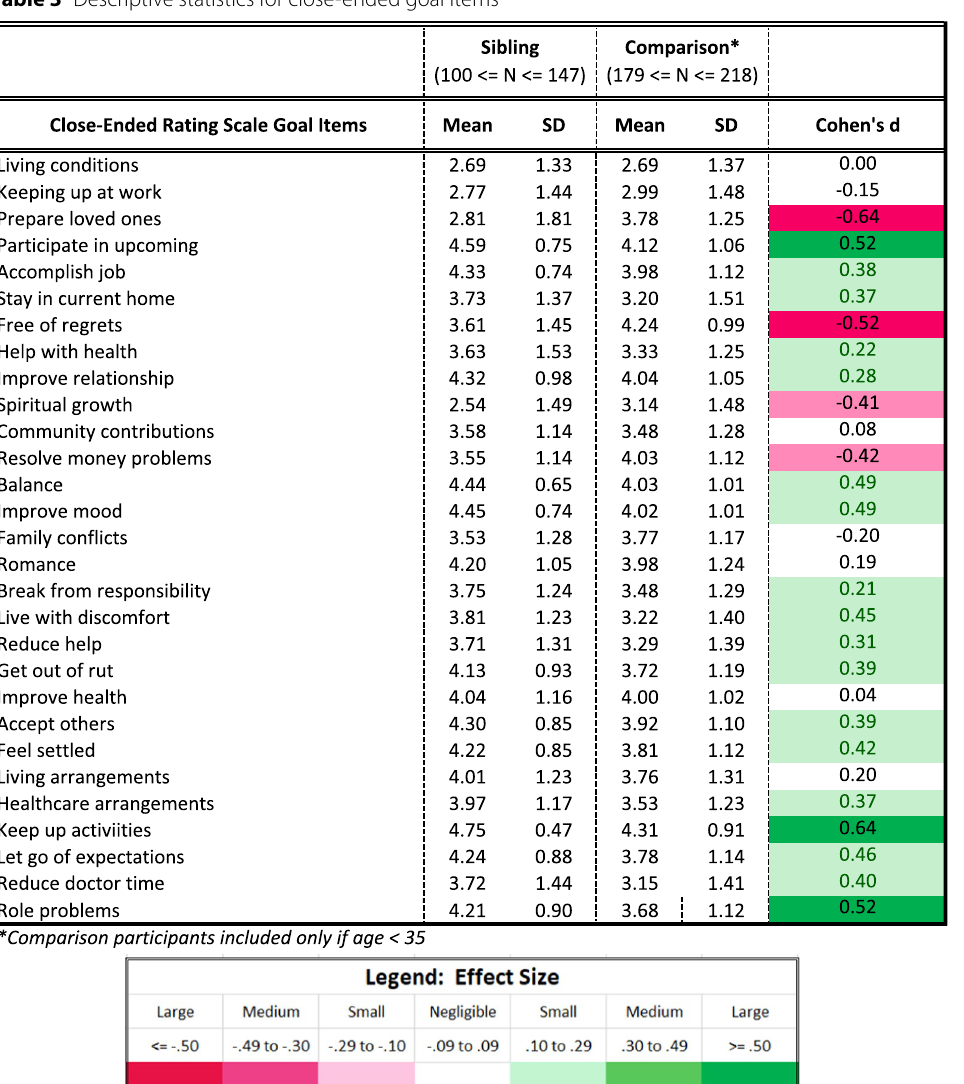
Table 3 Descriptive statistics for close-ended goal